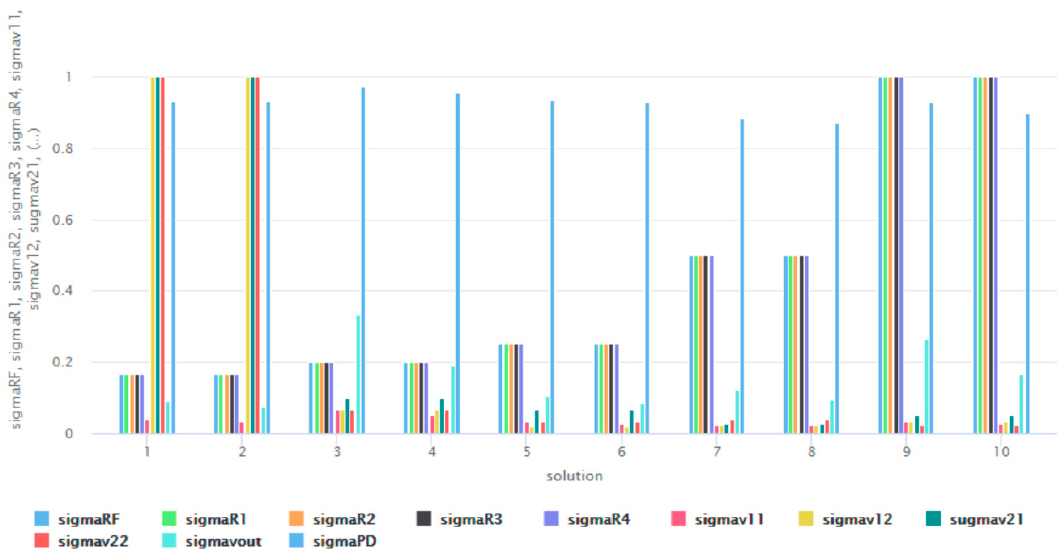
Figure 14. Sigma membership values of ten random designs of summing and subtracting amplifier.